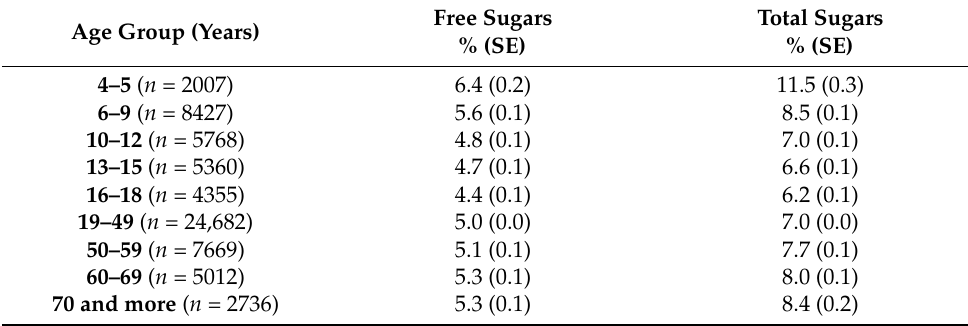
Table 6. Free sugar intake as percent of daily energy, split by age group.